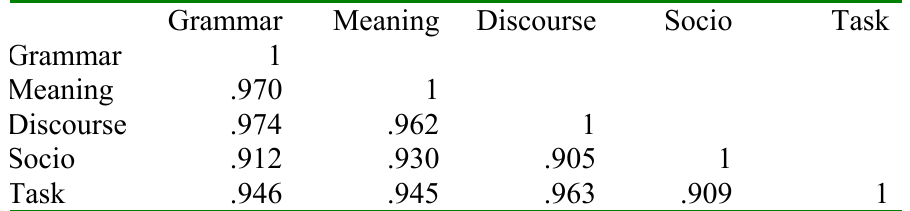
Correlation Analyses of Task 10